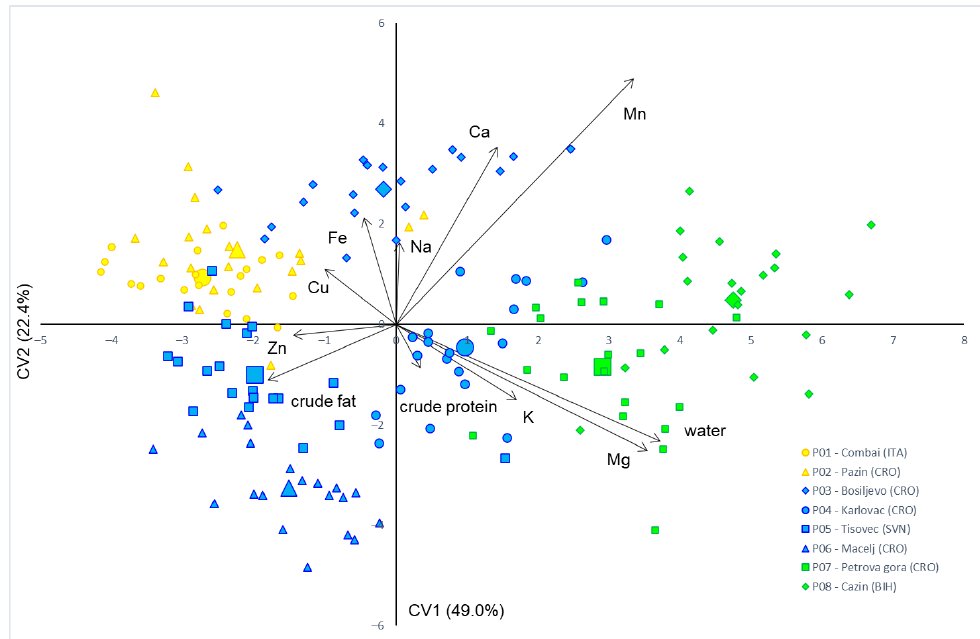
Figure 4. Discriminant analysis of eight sweet chestnut populations based on 11 chemical traits that were the most useful for maximum discrimination between studied populations. Each individual tree is indicated by a small sign, while the population barycenters are represented by larger ones. The color of the signs is related to the biogeographical region and management type: yellow color — sub-Mediterranean high-forest populations; blue color — continental high-forest populations; and green color — continental coppice populations. Canonical discriminant variate (CV).